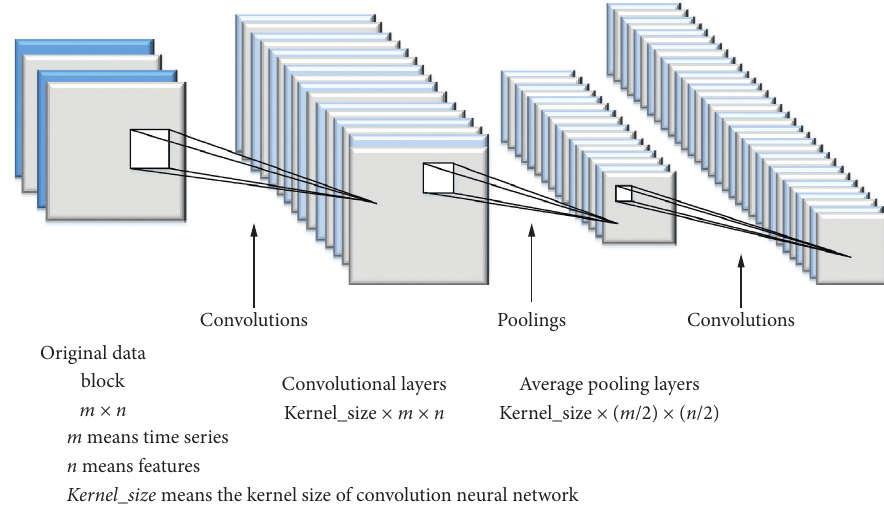
Figure 3: The basic structure of convolution kernel in this paper.